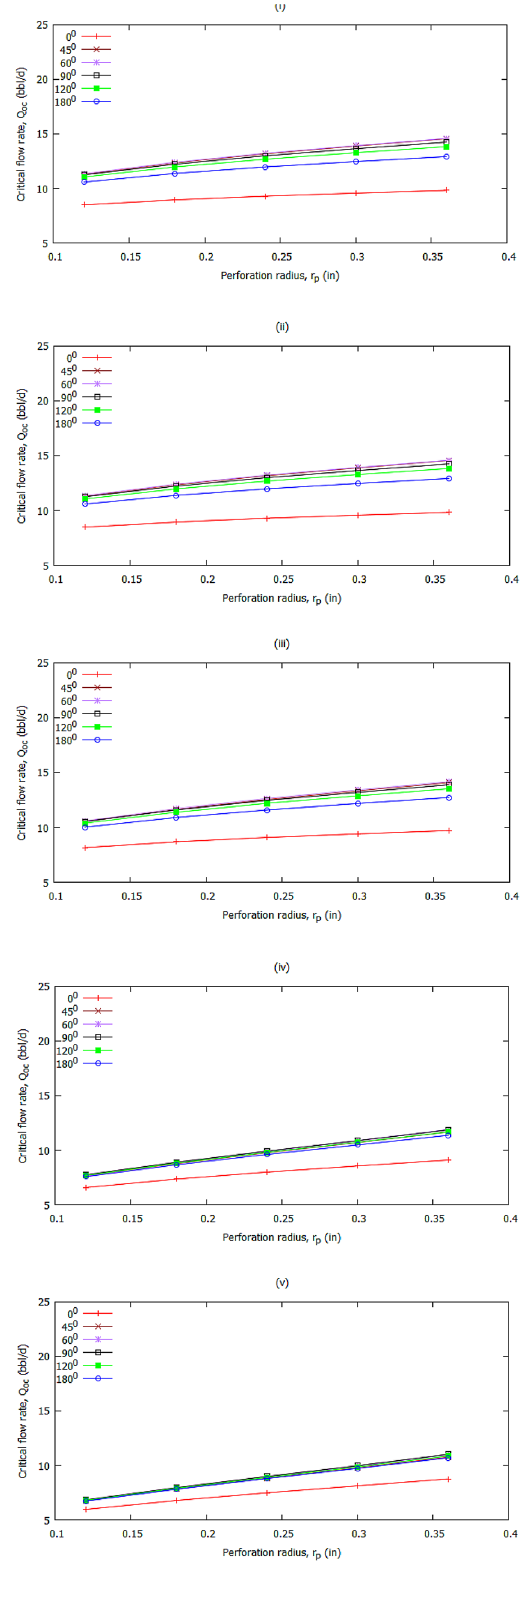
Fig. 4 Perforation length of 6 in and spacing between perforations on critical flow rate at different phasing angles and perforation